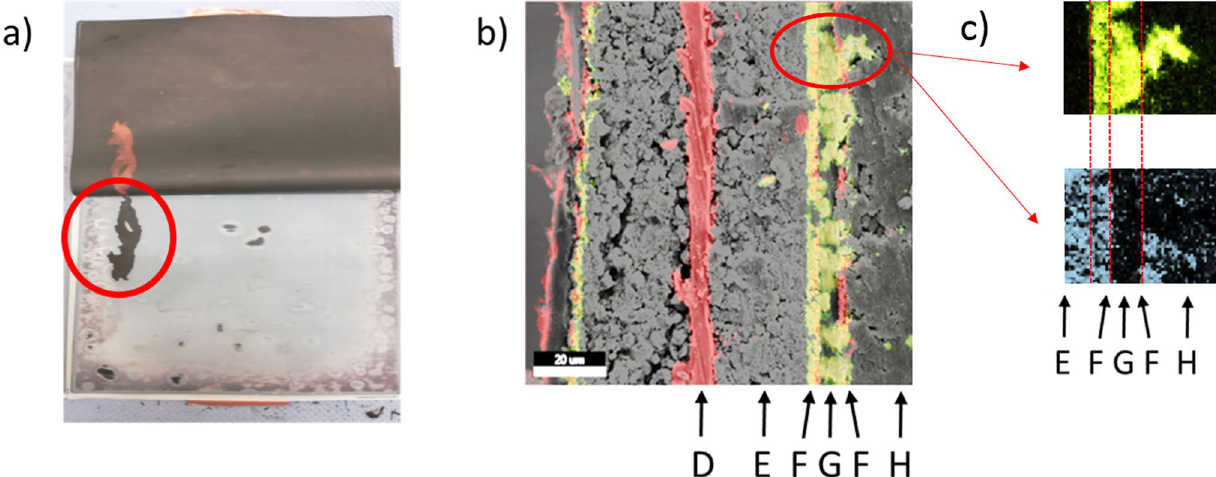
Figure 5. SEM–EDX analysis of cell 7. ( a ) The graphite layer remains on the separator; ( b ) SEM image with EDX mapping superimposed on a cross-section of a cathode foil (red circle on the left) which is connected to the separator and the graphite layer (from left to right) D: Al carrier foil, E: NMC layer, F: Al 2 O 3 coating of the separator foil (red), G: separator foil penetrated by copper (green), H: graphite layer; ( c ) EDX mapping of a copper dendrite, upper image: copper highlighted in green, lower image: oxygen highlighted in light